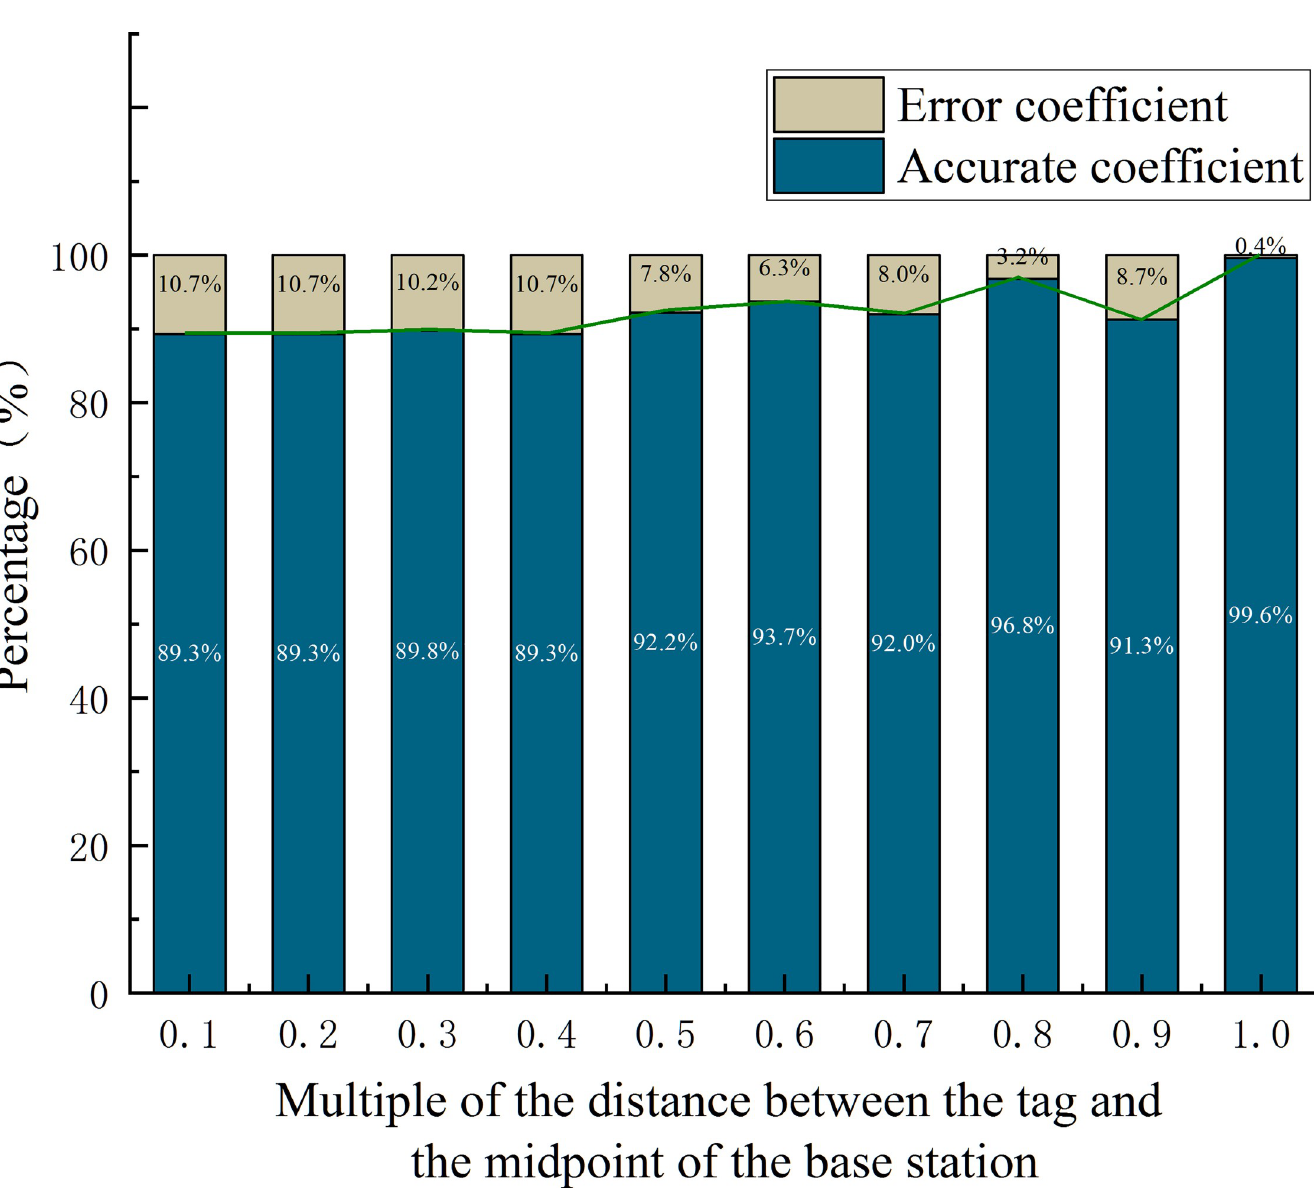
Fig 10. Error in experiment